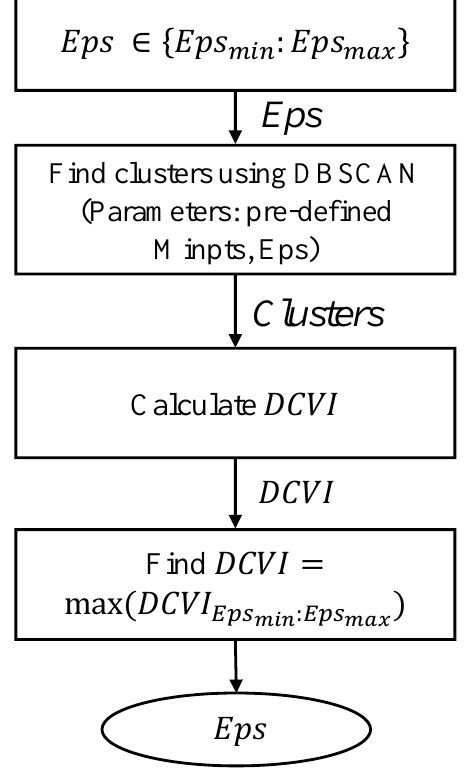
Figure 4. Flowchart for choosing the Eps value using